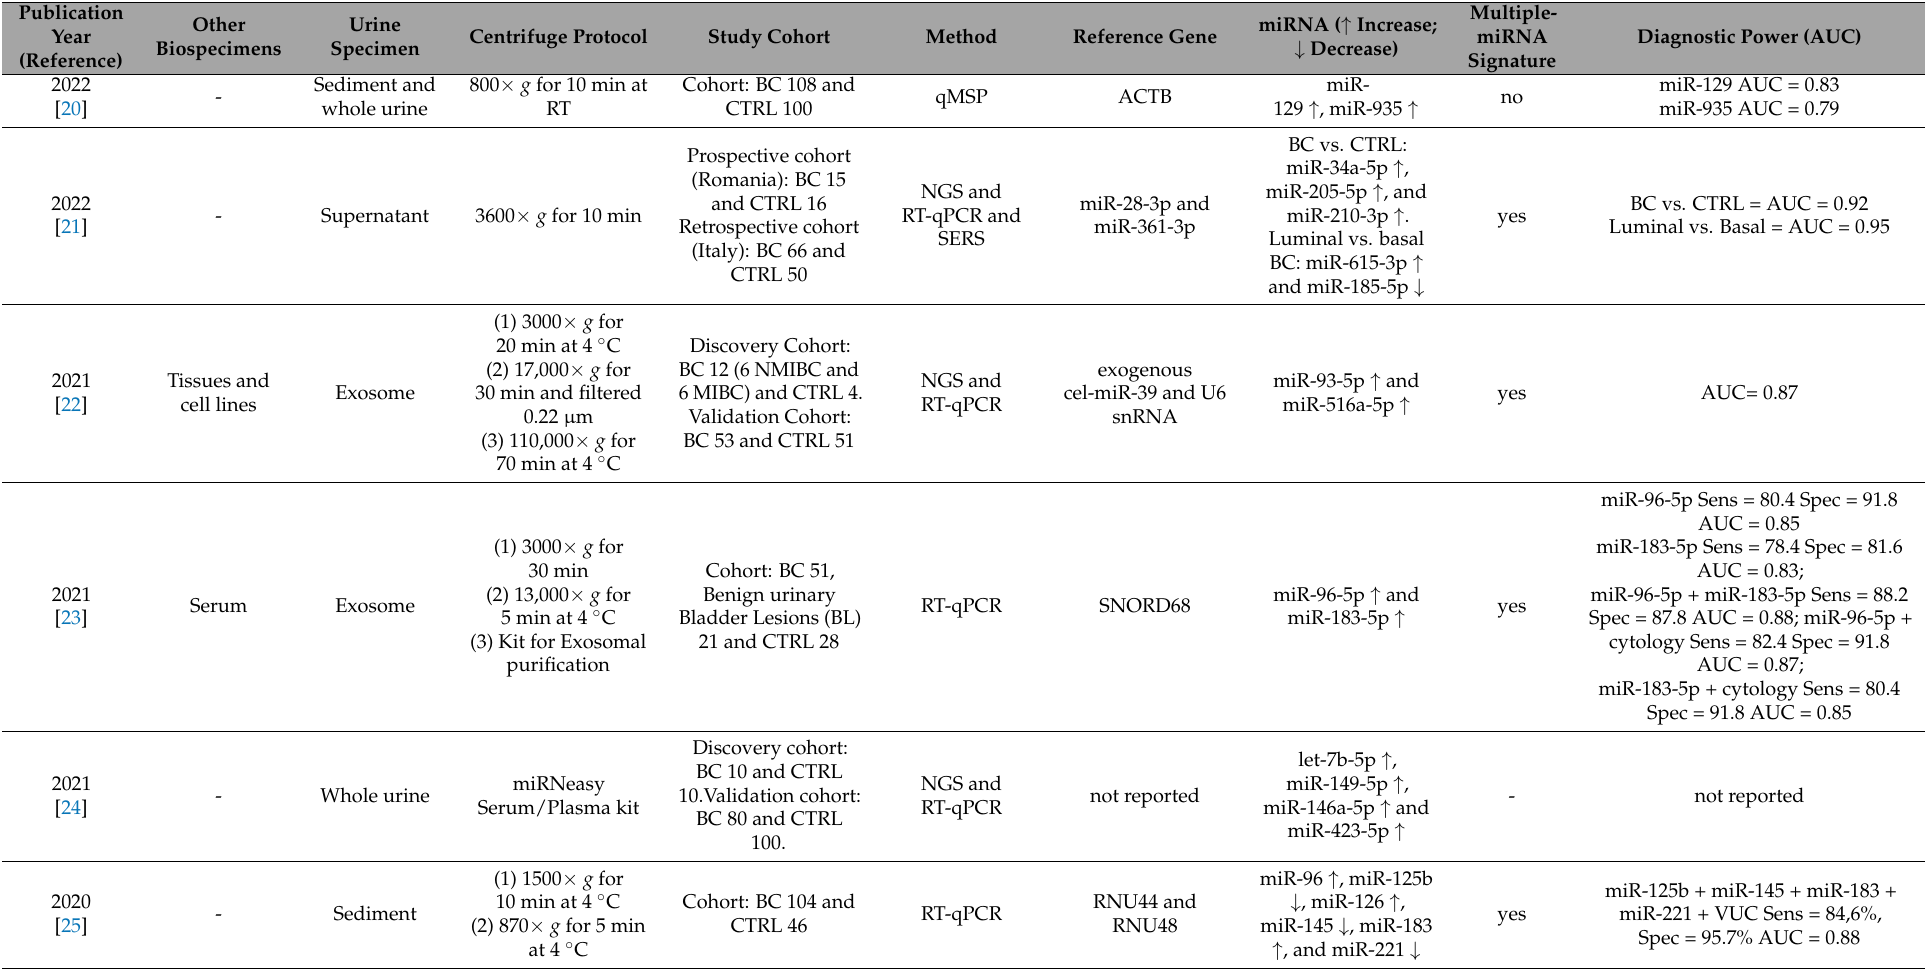
Table 1. Main features of each selected